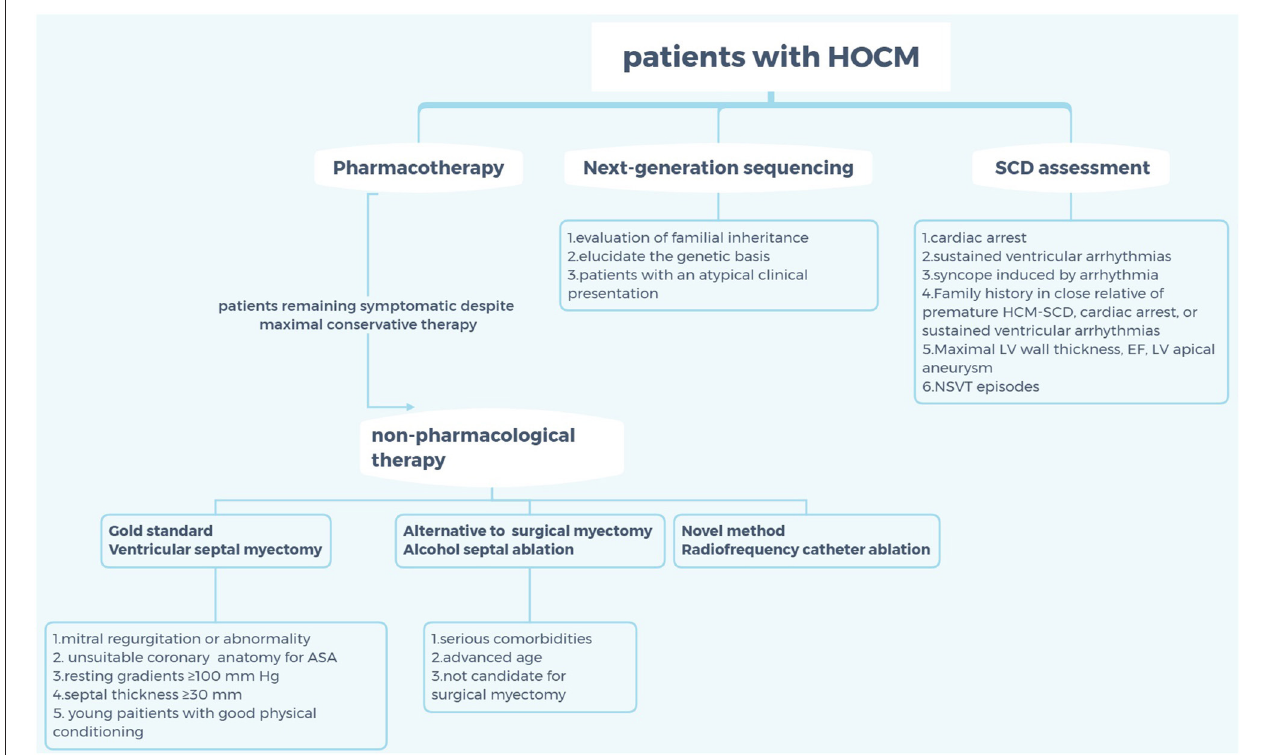
FIGURE 1 | Criteria for selection of non-pharmaceutical interventions for patients with hypertrophic cardiomyopathy. HOCM, hypertrophic obstructive cardiomyopathy; SCD, sudden cardiac death; HCM, hypertrophic cardiomyopathy; EF, ejection fraction; LV, left ventricle; NSVT; non-sustained ventricular tachycardia; ASA, alcohol septal